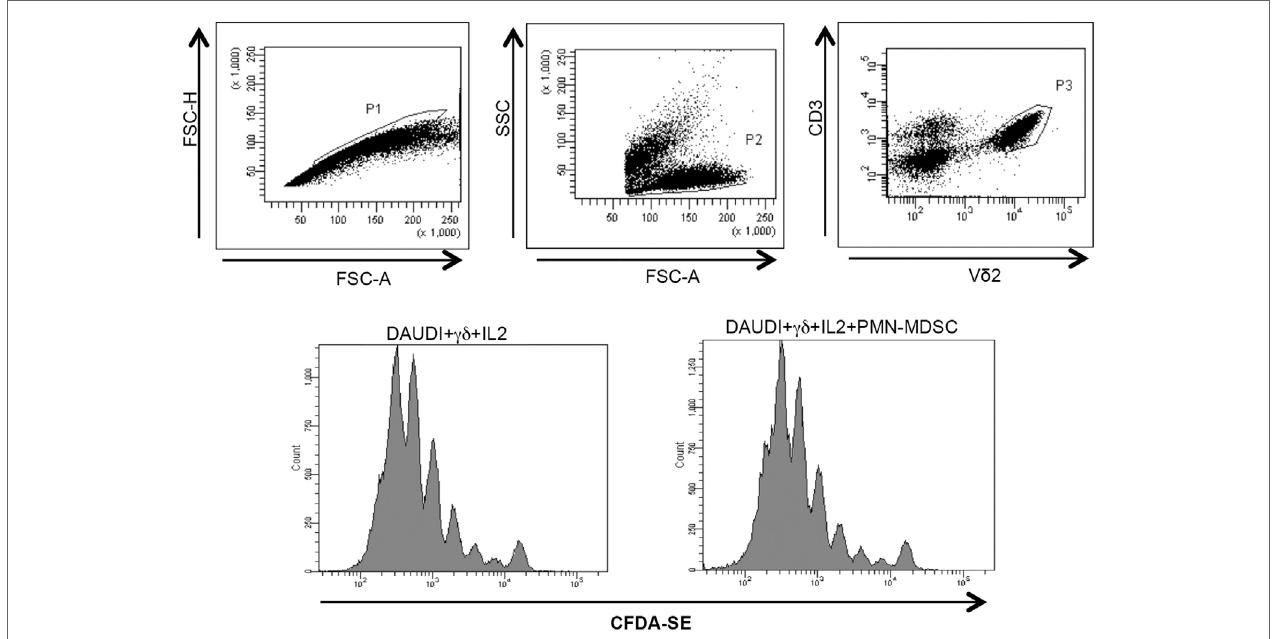
FigUre 5 | PMN-myeloid-derived suppressor cells (MDSC) does not inhibit Daudi-induced V δ 2 T cell proliferation . Purified γδ T cells labeled with CFDA-SE were stimulated with Daudi cells and IL-2 in the presence of PMN-MDSC. After 5 days, V δ 2 + T cells proliferation was evaluated by flow cytometry. Representative histogram plots of one out of three independent experiments showing V δ 2 T cells proliferation in the indicated